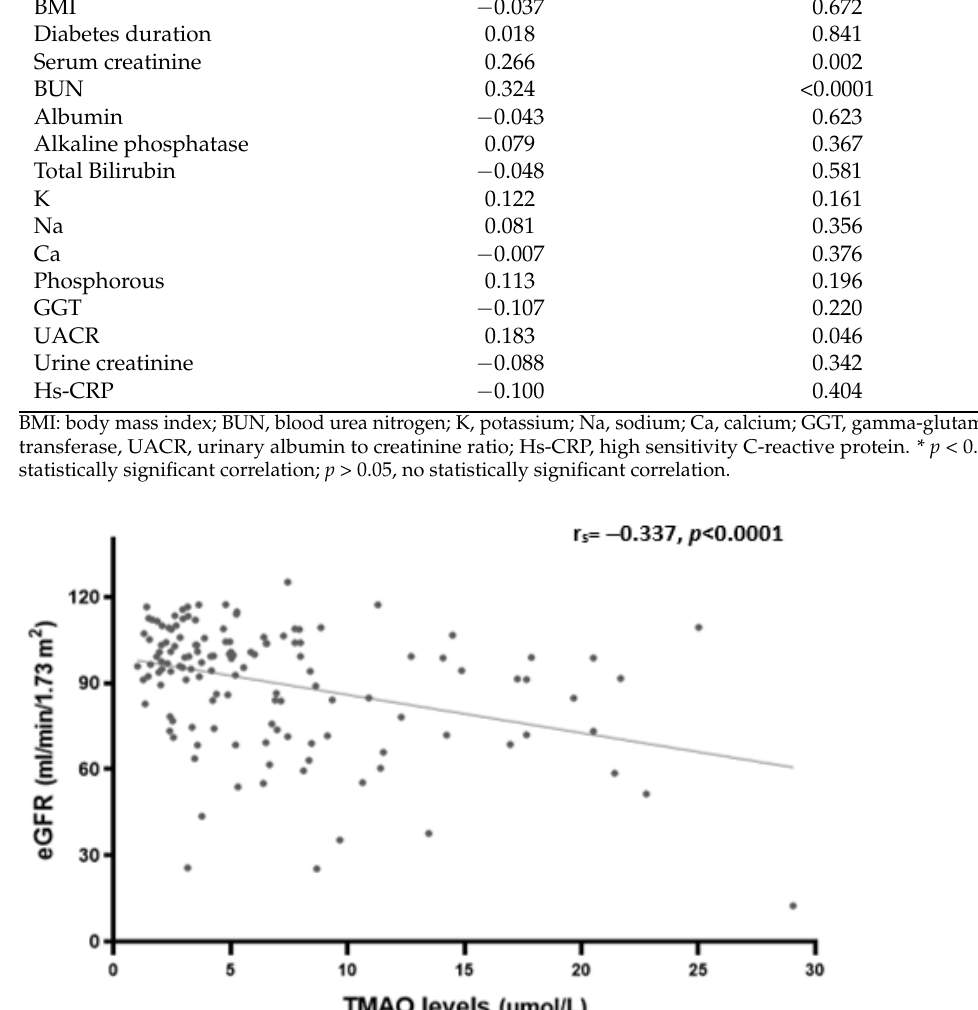
Table 3. Spearman’s rank correlation coefficient to assess the relationships between TMAO and markers of kidney function.